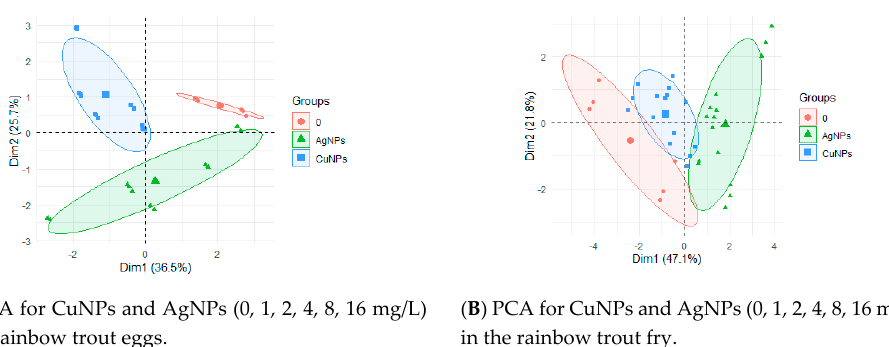
Figure 5. PCA by groups, depending on the fish life stage and the type of nanometal used.